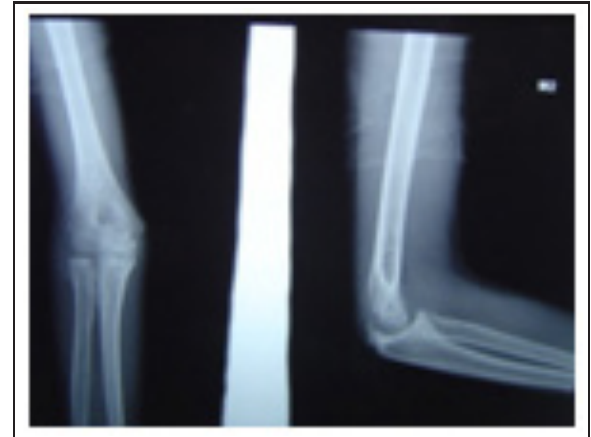
Figure 4. Photographs, at ten months latest follow up, show excellent range of movement of the elbow